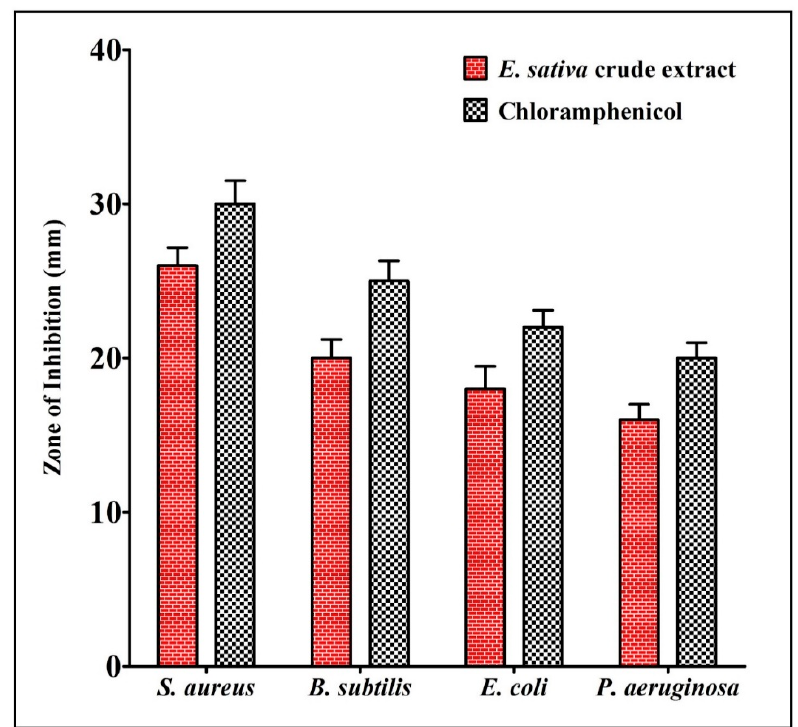
Figure 3. Antibacterial activity (zone of inhibition) against E. coli , P. aeruginosa , B. subtilis and S. aureus in comparison with positive control chloramphenicol. The test was carried out in triplicate and the data represent the mean ± SD, n = 3.